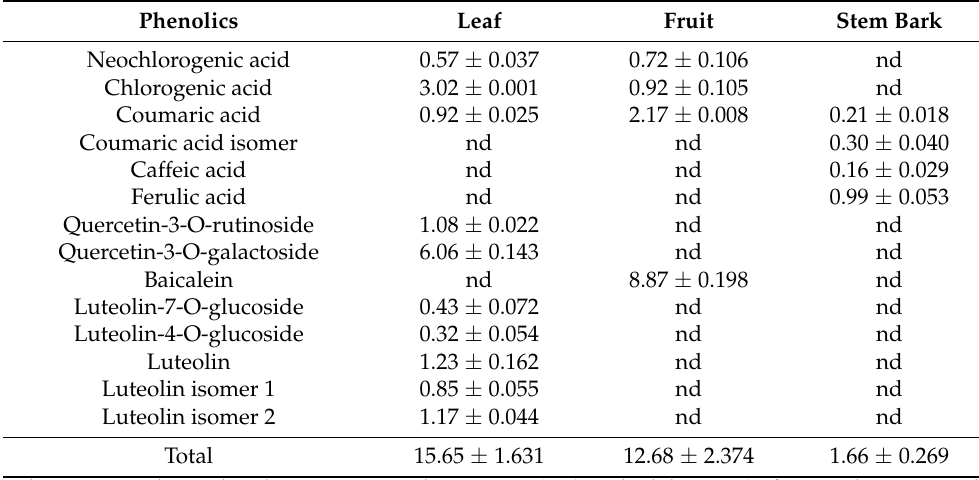
Table 2. The average levels and standard deviation (SD) of the individual phenolics identified in P. hybrida ’s extracts expressed as mg/g of dry